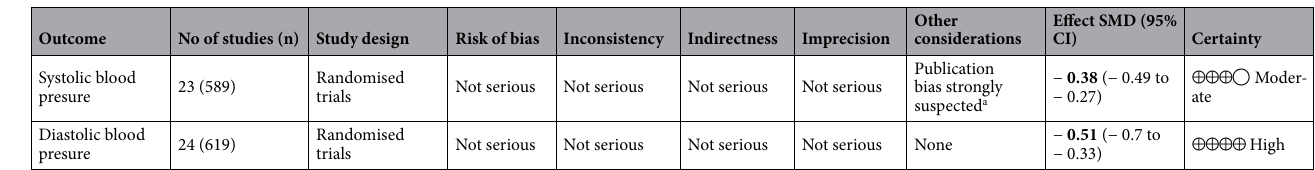
Table 3. Quality of evidence by Grading of Recommendations Assessment , Development and Evaluation (GRADE). n, number of participants; CI, confidence interval; SMD, standardised mean difference. a Four omitted results are expected by trim and fill funnel plots. Significant values are in